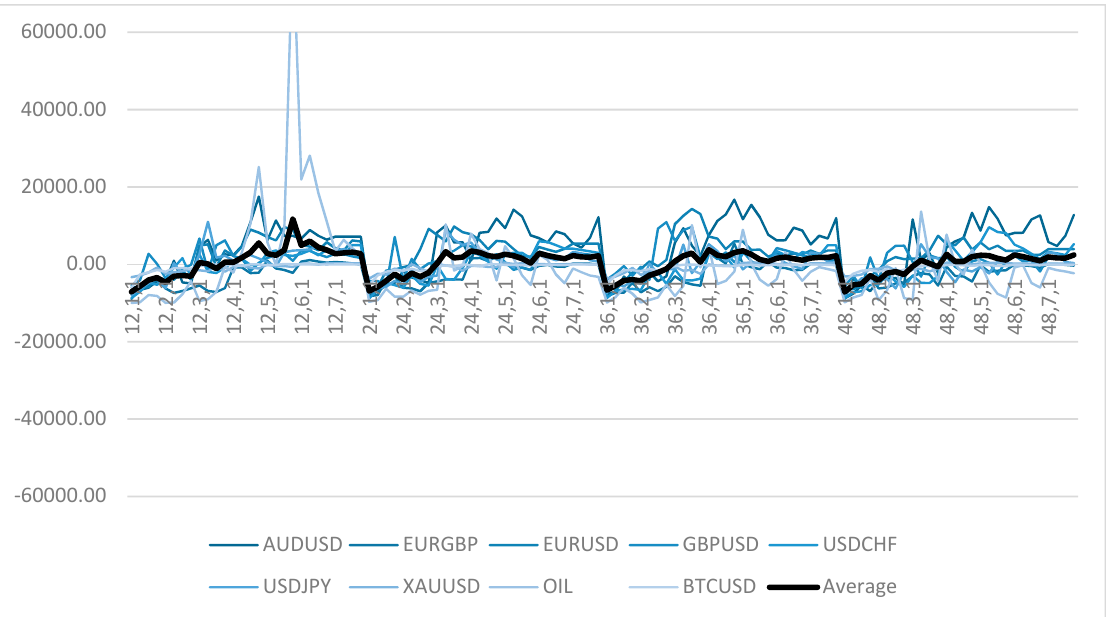
Figure 16. Net Profits of experiment (h) for various combinations of N, x , y .